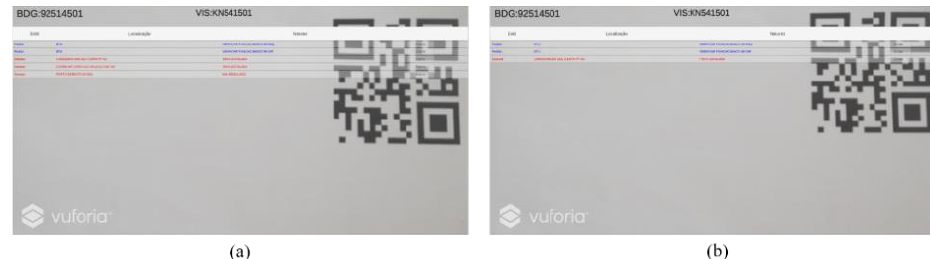
Figure 7. Screenshots of the system execution on the Android platform while Marker identification by Vuforia ( a ) after and ( b ) before operator tasks correction.